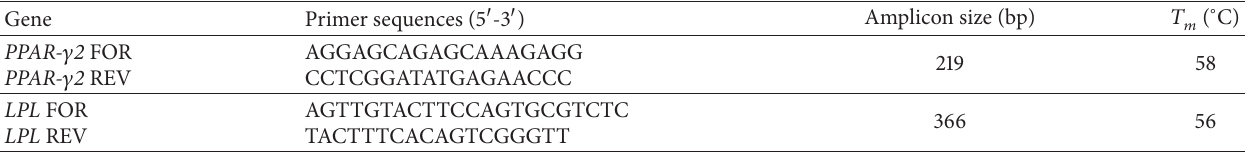
Table 2: Primers used for